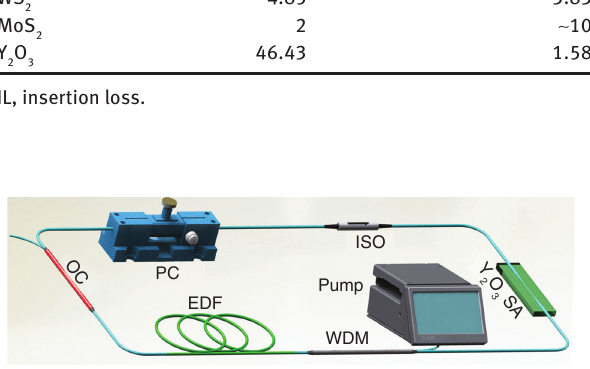
Figure 4: Experimental installation diagram of the proposed fiber